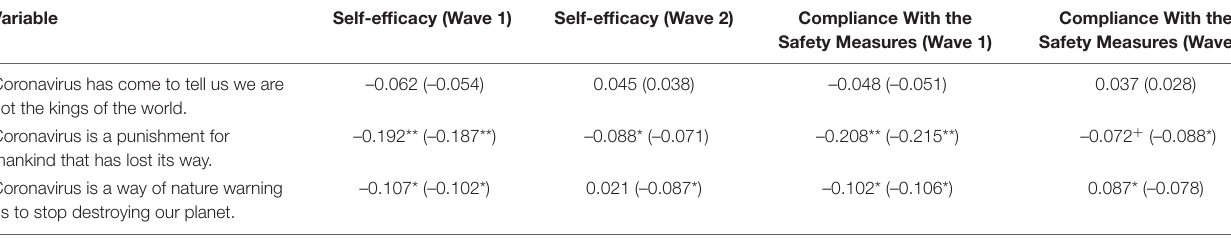
TABLE 6 | Higher-order beliefs about the pandemic, self-efficacy, and compliance with the safety measures: Correlations. Variable Compliance With the